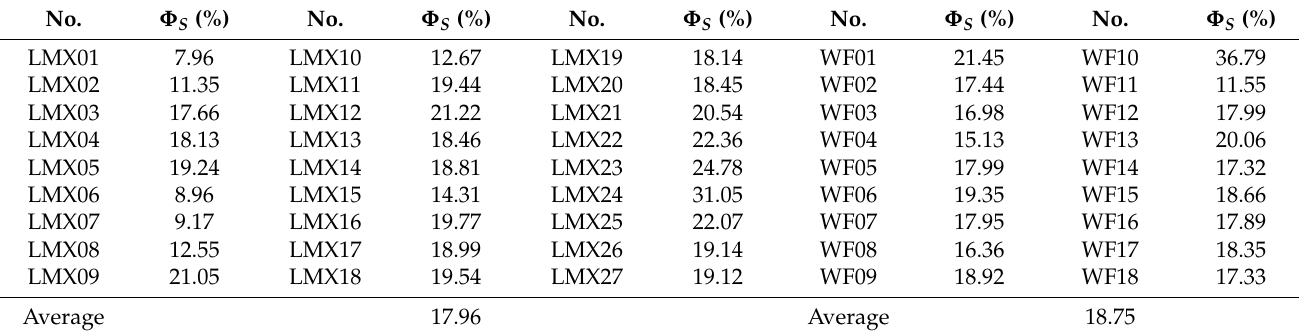
Figure 9. SEM images utilized for calculation of pores associated with organic matter in shales from the WF-LMX Formation. The left graph is the original SEM for the ( a ) WF Formation and ( b ) LMX Formation, and the right graph is the software to delineate the pore image for the ( a’ ) WF Formation and ( b’ ) LMX Formation, respectively. Table 4. Results of the surface organic matter porosities (Φ S , %).